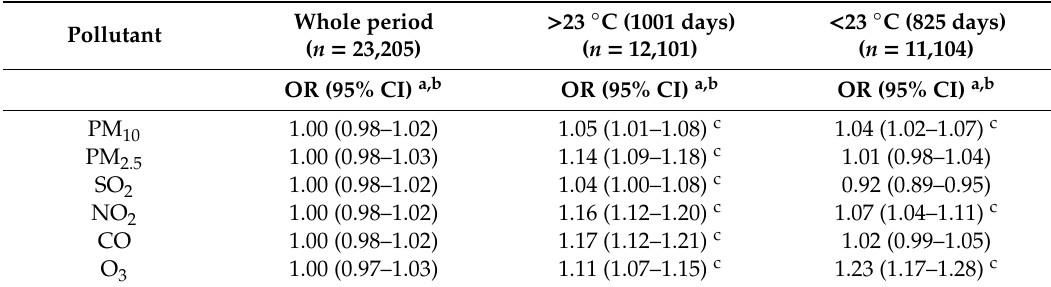
Table 3. Association between exposure to air pollutant and hospital admissions for peptic ulcer in a single pollutant model for Taipei, Taiwan,